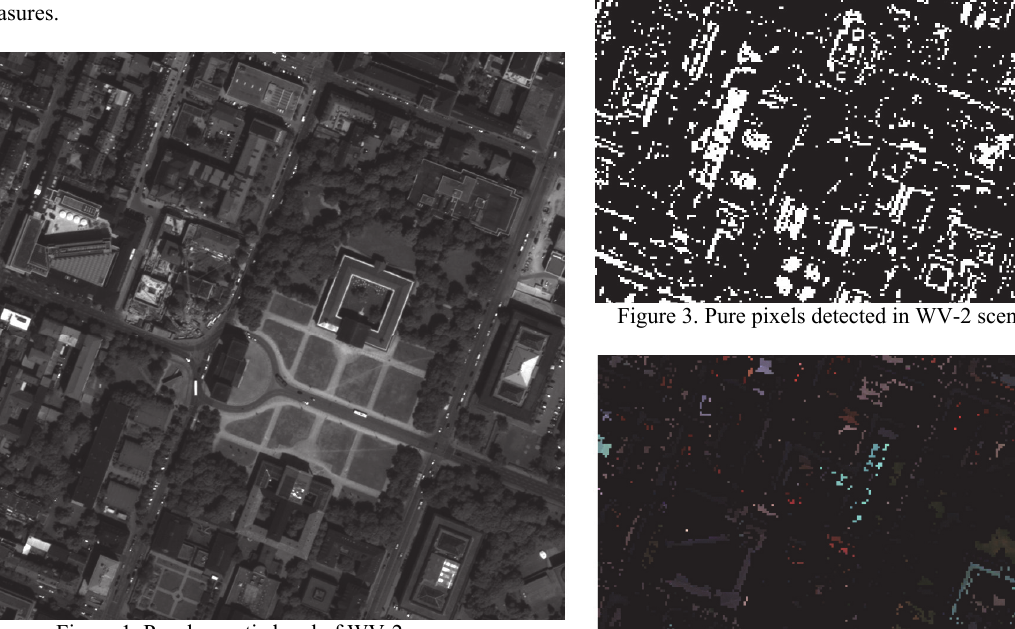
Figure 1. Panchromatic band of WV-2 scene.